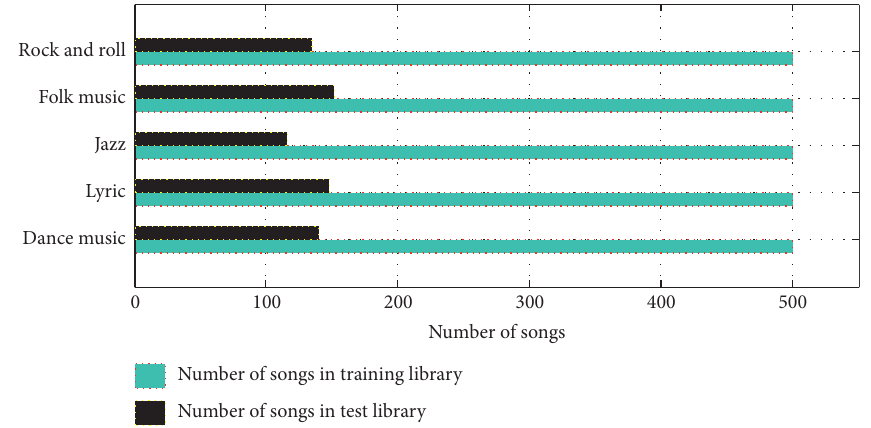
Figure 4: Music training and testing database.